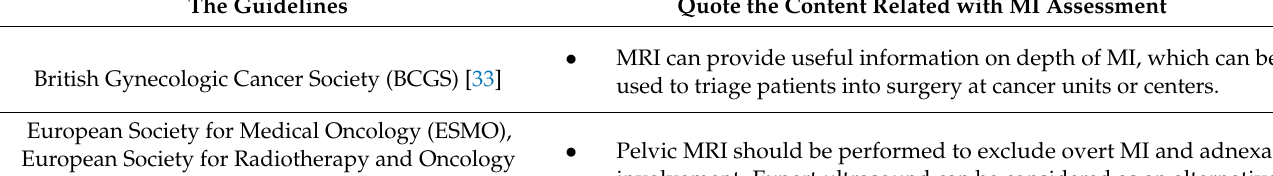
Table 5. Current clinical guidelines related to MRI assessment of MI in